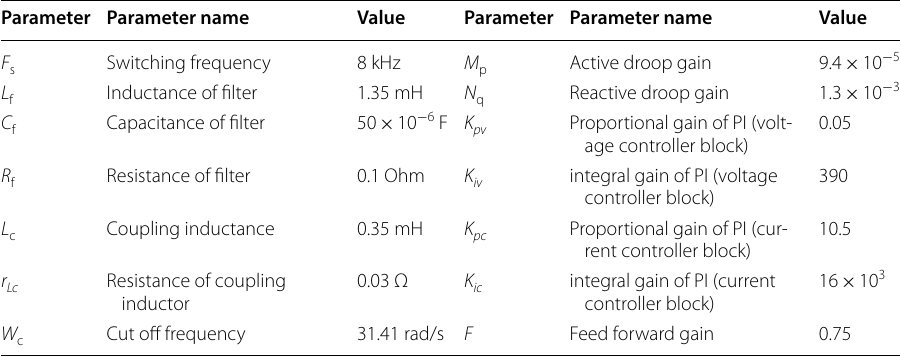
Table 1 Inverter parameters